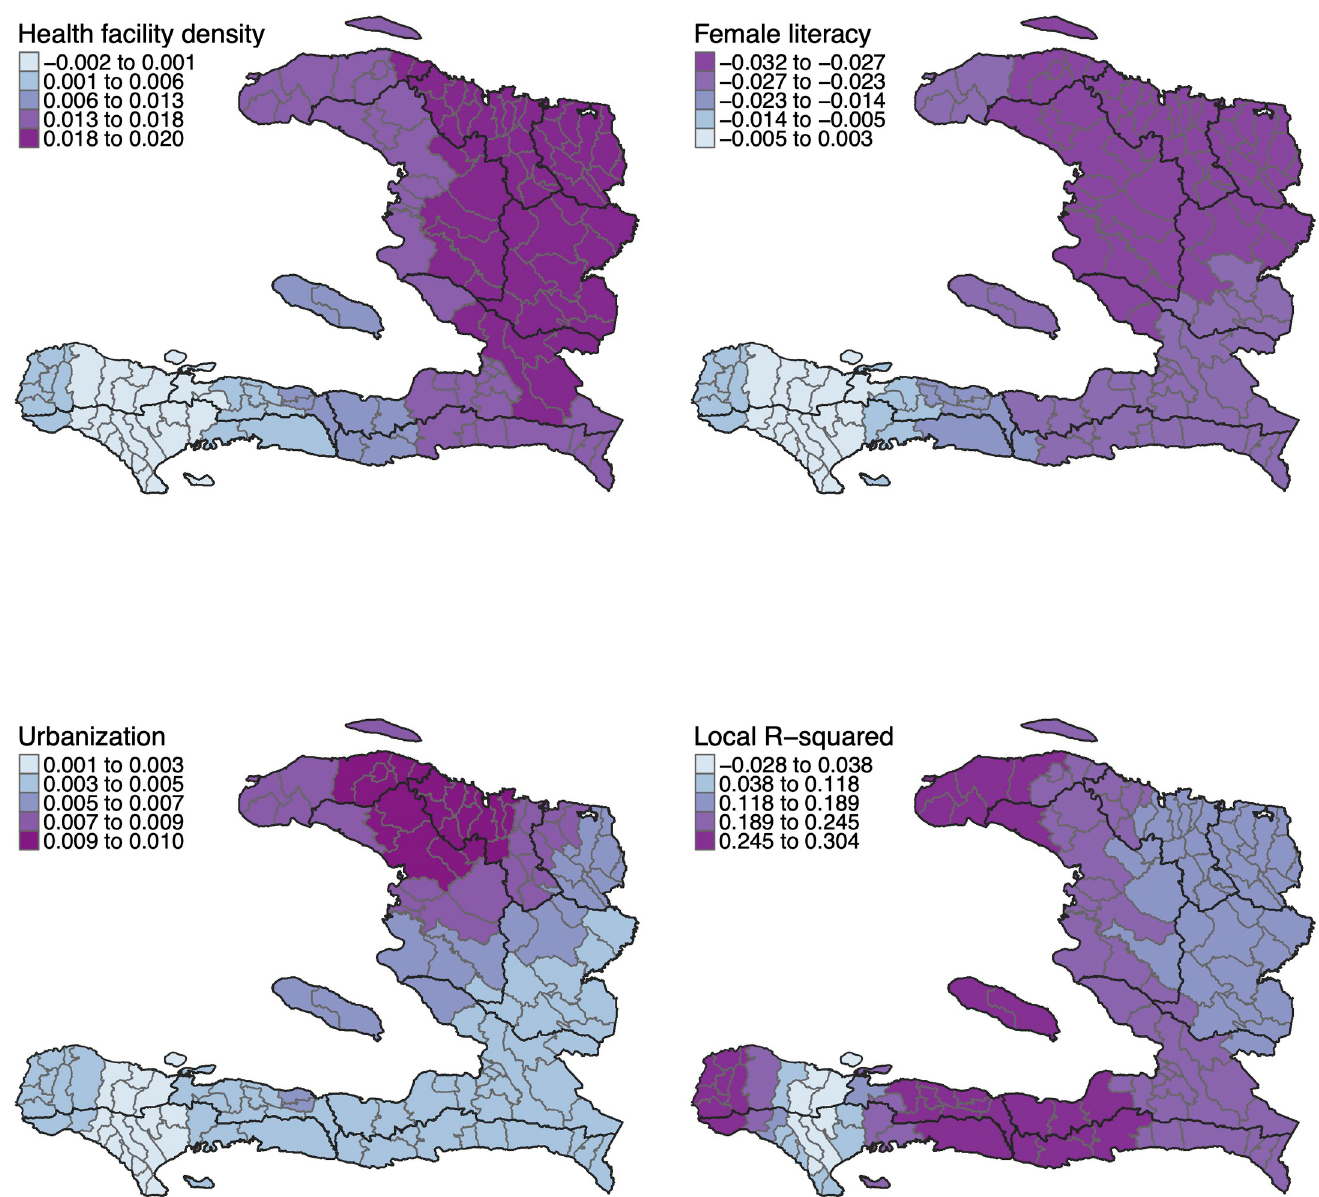
Fig 4. Local regression coefficients and R 2